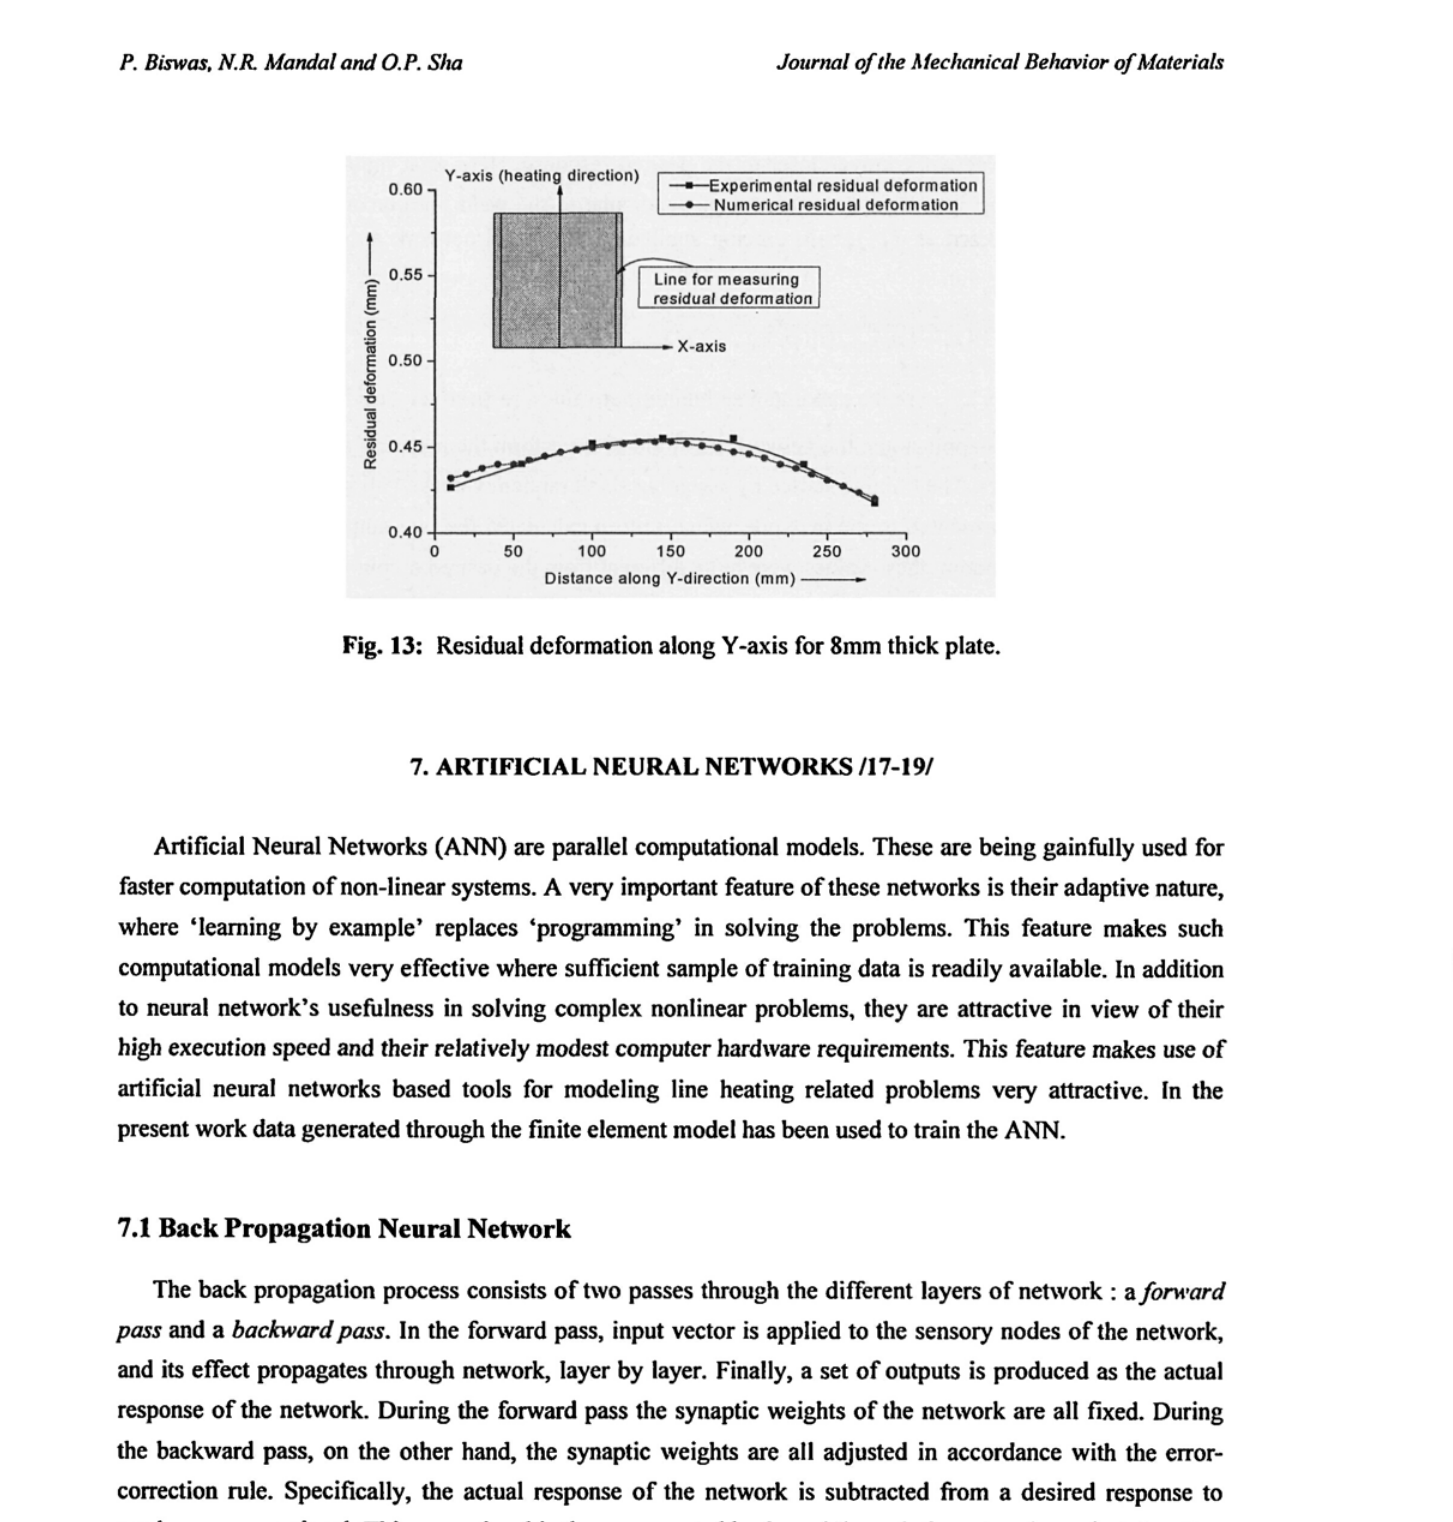
Fig. 13: Residual deformation along Y-axis for 8mm thick